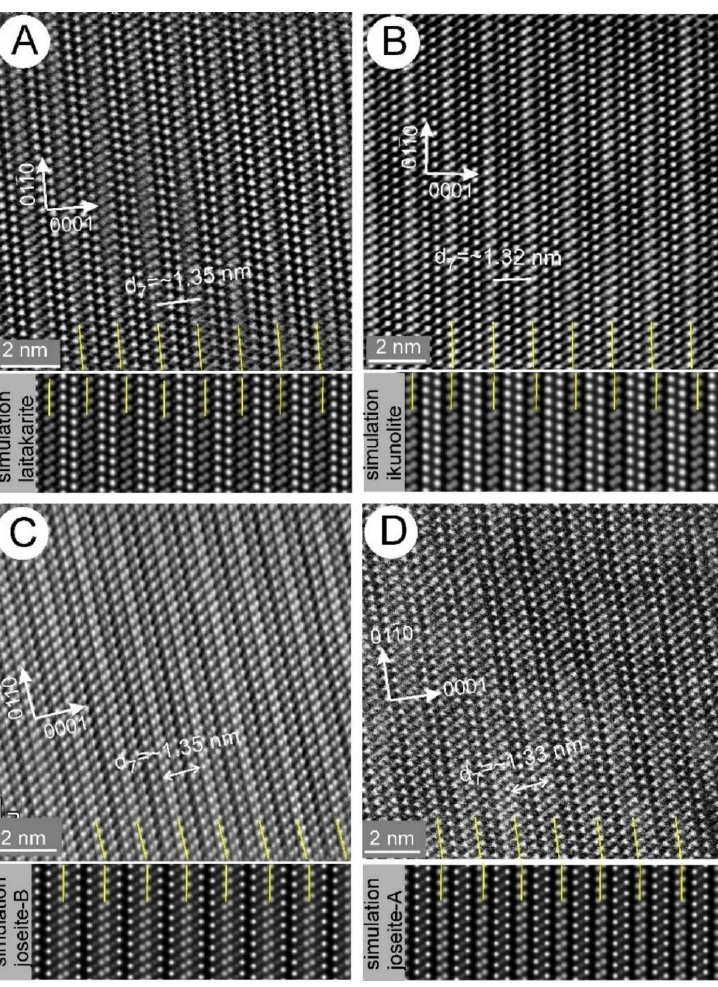
Figure 6. HAADF STEM images and respective STEM simulations (below each image) in ( A – D ) showing ordered stacking sequences on the [21̅1̅0] zone axis of each of the four analysed phases as labelled: laitakarite (Ltk) in ( A ), ikunolite (Ik) in ( B ), joséite-B (Jo-B) in ( C ), and joséite-A (Jo-A) in ( D ). The double Bi–Bi pairs that separate the layers are marked by yellow lines on both images and simulations. Note that the Bi–Bi pairs are closely spaced. The images were obtained using drift-corrected frame integration (DCFI) procedures and application of filters to eliminate